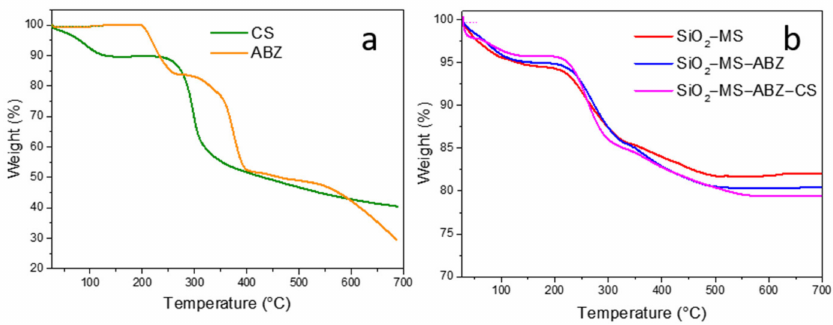
Figure 3. Thermograms of ( a ) pure chitosan and Albendazole, and ( b ) mesoporous silica, Albendazole-loaded mesoporous silica and Albendazole-loaded mesoporous silica coated with